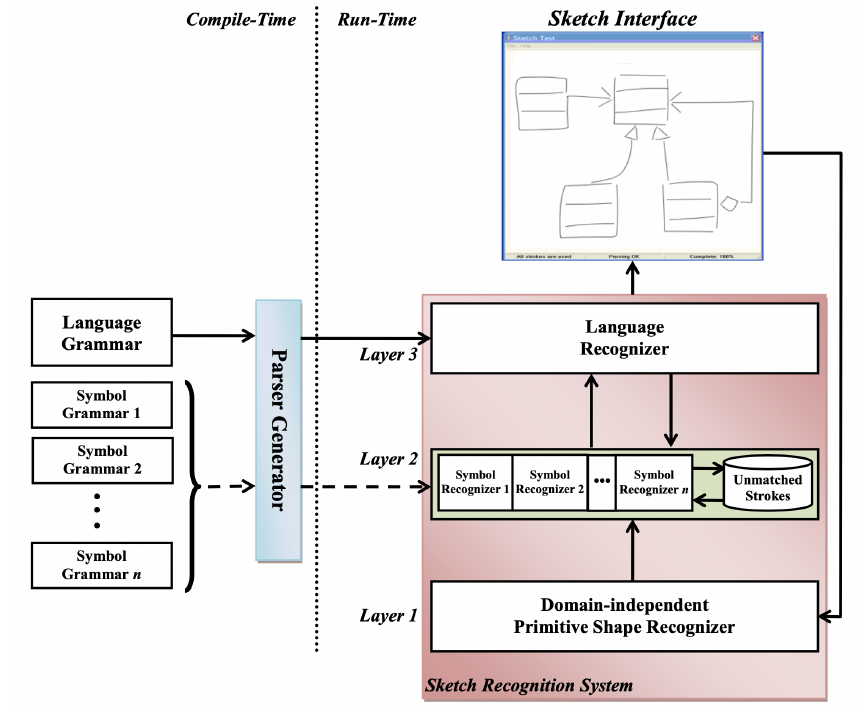
Figure 2. The process of generation of the sketch recognition